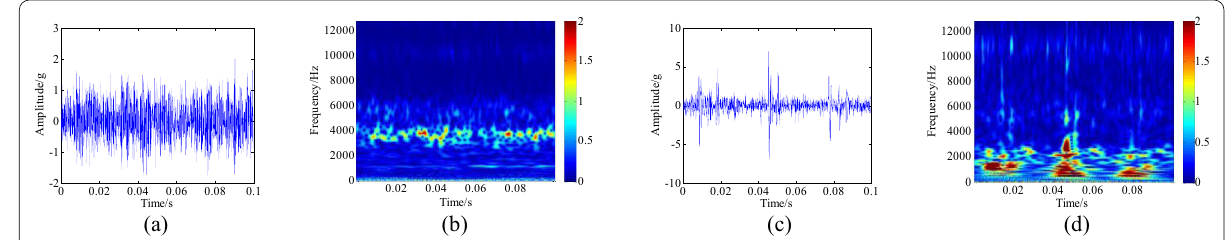
Figure 5 Horizontal vibration signals and corresponding TFRs of bearing 1-1: (a) Raw signal of first sampling interval; (b) CWT TFR of first sampling interval; (c) raw signal of last sampling interval; (d) CWT TFR of last sampling interval